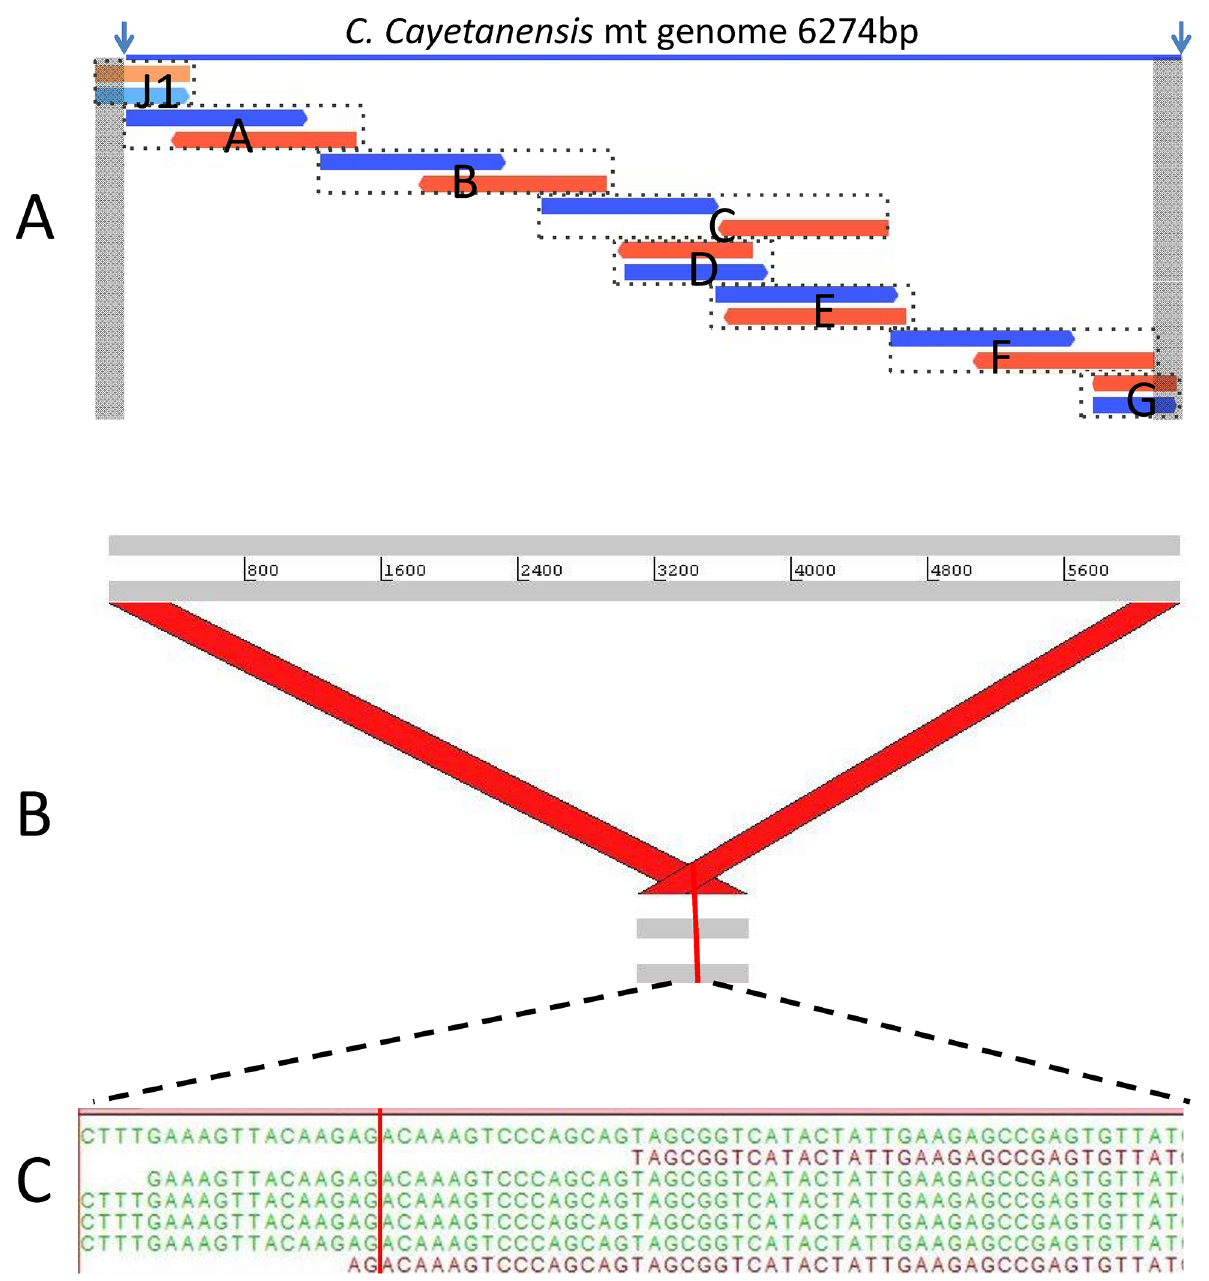
Fig 1. Confirmation of the C . Cayetanensis mt genome sequence. A) Overlapping PCR fragments used to confirm the C . cayetanenesis mt genome sequence and concatemeric structure. PCR fragments are shown with dotted lines. Forward sequence reads are shown in blue or orange and reverse reads are shown in red or light blue. Terminal grey bands indicate identical sequence regions. B) A 659 bp contig constructed using overlapping junction PCR fragment sequences (see Table 2) is represented in gray. Diagonal red bars represent portions of the junction PCR product mapping to the ends of the complete C . cayetanensis mt genome. C) WGS reads spanning the junction region in the initial mt assembly. The vertical red lines mark the tail:head